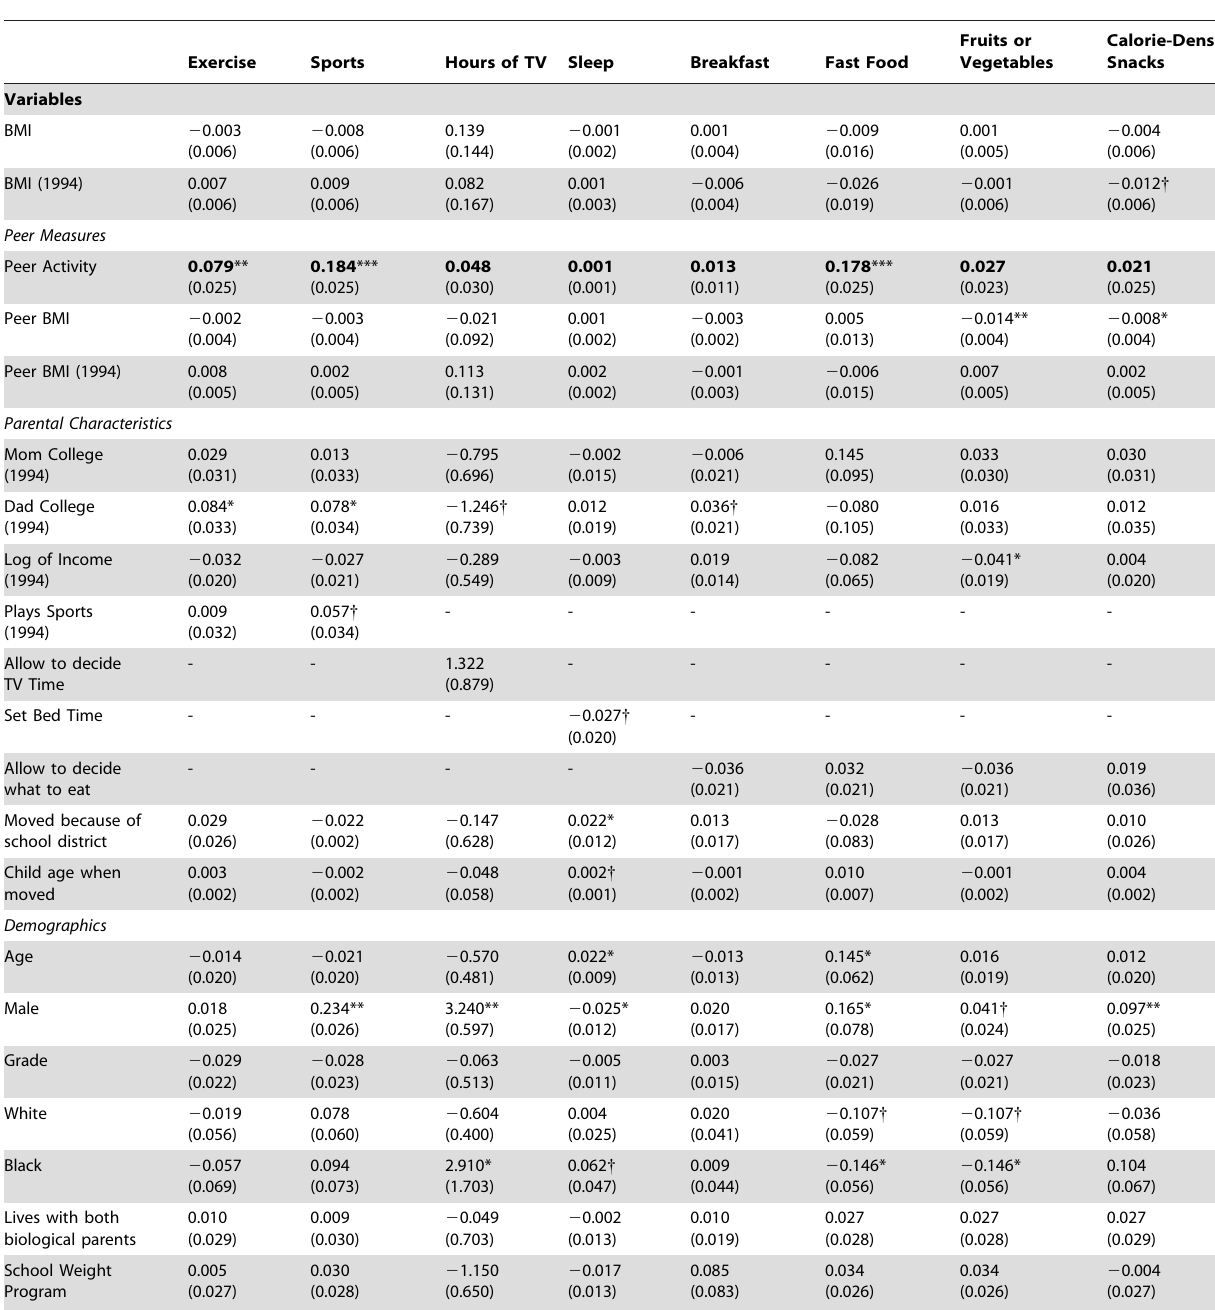
Table 6. Detailed Estimates from Full Specification (with school–level Fixed